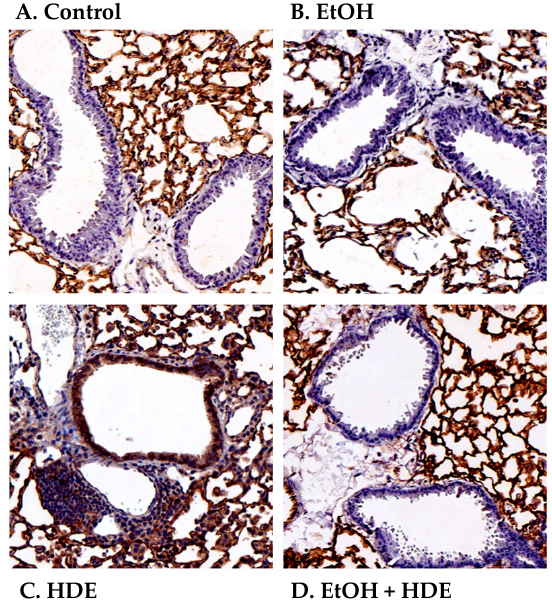
Figure 4. Alcohol blocks ICAM-1 localization in airway epithelium of mice instilled with HDE. Mice were fed either water (control) or 20% ethanol (EtOH) for 8 weeks with or without intranasal instillation of HDE. Saline inhalation in either control ( A ) or EtOH-fed mice ( B ) exhibit minimal airway epithelial ICAM-1 staining in luminal cells. Mice inhaling HDE ( C ) show prominent ICAM-1 staining (brown) on apical regions of the luminal airway epithelium and extensive mononuclear cell aggregates (purple). Ethanol pretreatment ( D ) blocks the HDE-stimulated upregulation of localized ICAM-1. Images are representative of sections from at least three mice per treatment group.